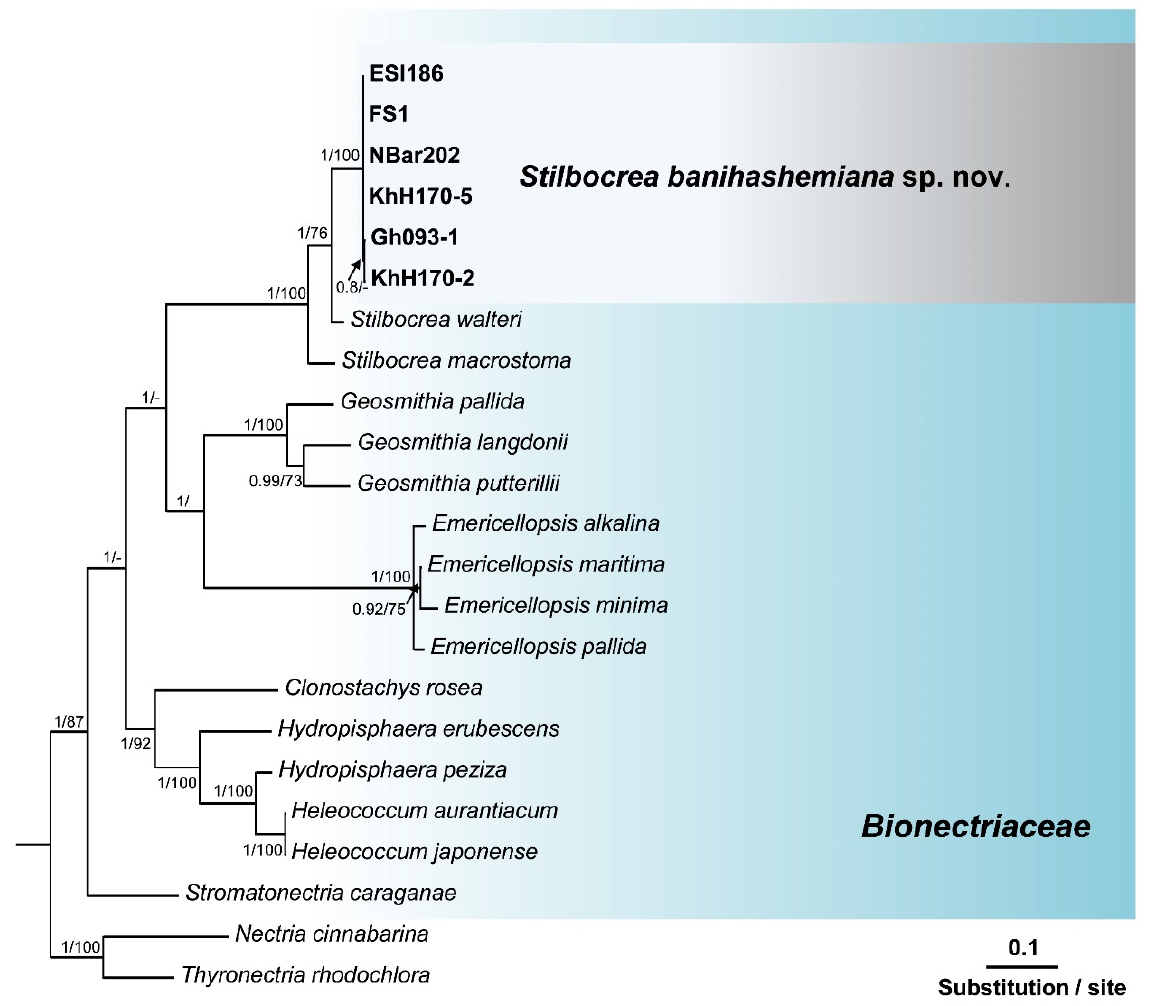
Figure 5. Phylogenetic position of Stilbocrea banihashemiana sp . nov. from infected fig and loquat trees sampled in Fars Province, Iran within Bionectriaceae : relationships among 15 Bionectriaceae members based on Bayesian analysis of multigene genealogies of ITS (internal transcribed spacers 1 and 2 and 5.8S gene of rDNA), tef1 (translation elongation factor 1- α ) and rpb2 (the second largest subunit of RNA polymerase II) sequences. Isolates in bold were sequenced in the present study. Numbers on the nodes are Bayesian posterior probability values (BI–PP) followed by maximum likelihood bootstrap values (ML–BS) and fully supported branches (BI–PP = 1/ML–BS = 100). The tree was rooted to two Nectriaceae members Nectria cinnabarina and Thyronectria rhodochlora ; FS1 = ex-type = CBS 148864. Isolates recovered from infected fig, and loquat trees in Iran are indicated in bold . Arrows represent the exact position of supporting values in the phylogenetic tree.